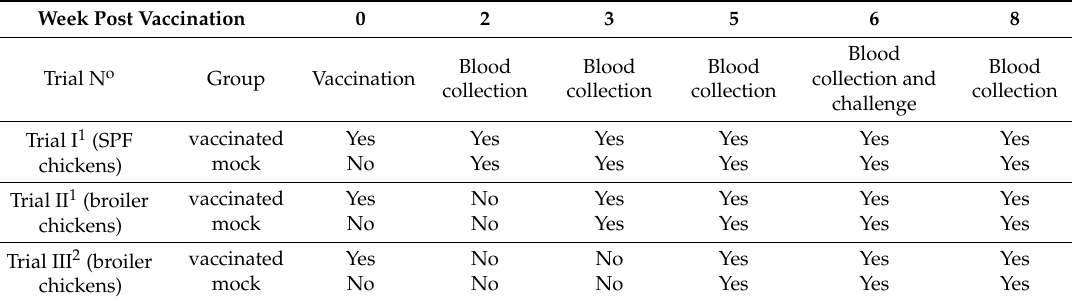
Table 1. Overview of the experimental